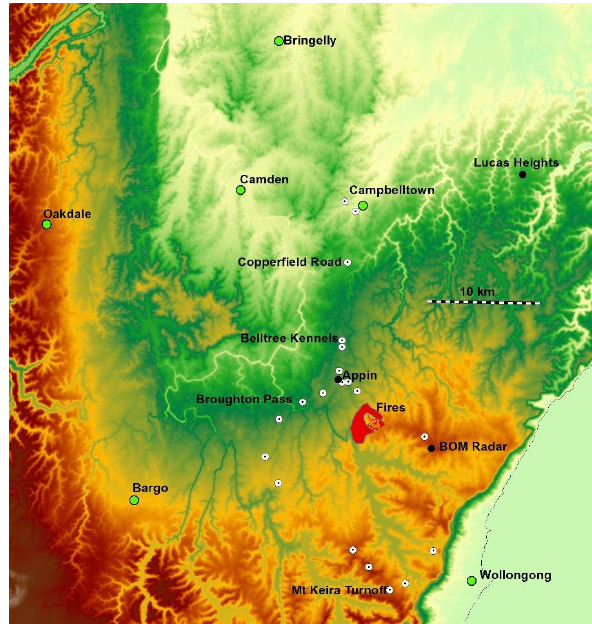
Figure 2. Detail of the fires and nearby air quality measurement lo- cations. Green dots are reference air quality monitors; yellow dots are repeat measurements using the handheld air quality monitor. Red dots are other permanent monitors. The background is air- photo mosaic from Land and Property Information